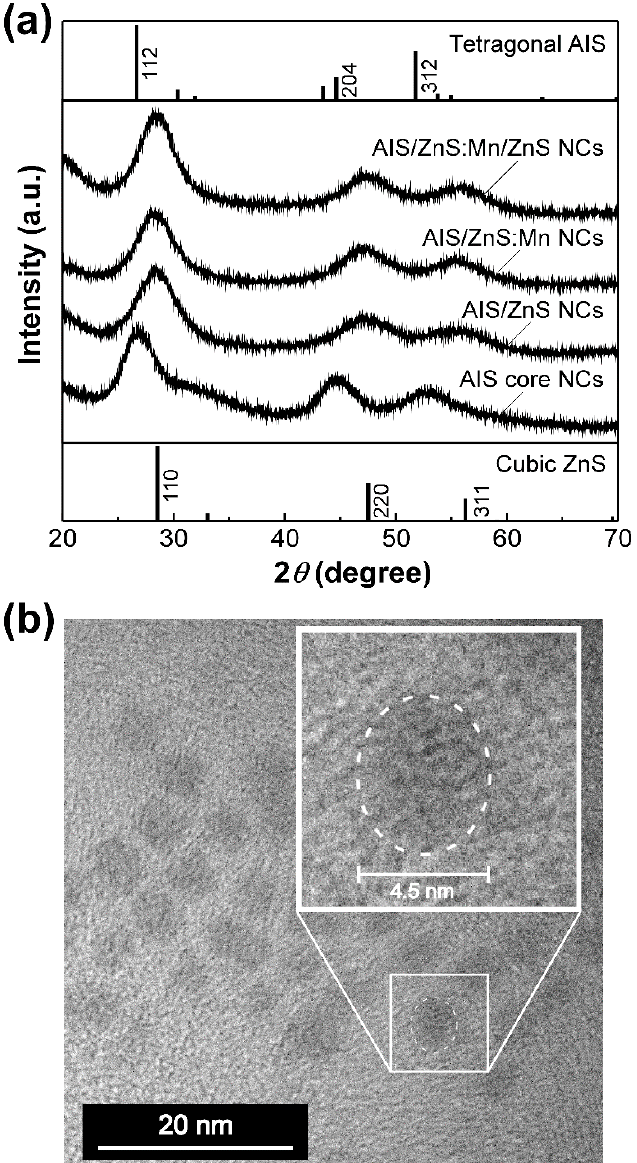
Figure 1. ( a ) XRD patterns of AgInS 2 (AIS) core NCs, AIS/ZnS core/shell NCs, AIS/ZnS:Mn core/shell NCs and AIS/ZnS:Mn/ZnS core/shell/shell NCs. For comparison, upper and lower profiles in this fi gure are the XRD patterns for bulk materials of tetragonal AgInS 2 (PDF# 00-0251330), cubic ZnS (PDF# 00-0050566), respectively. ( b ) TEM image of AIS/ZnS:Mn/ZnS NCs. The inset denotes the magnified image of circularly dashed area.